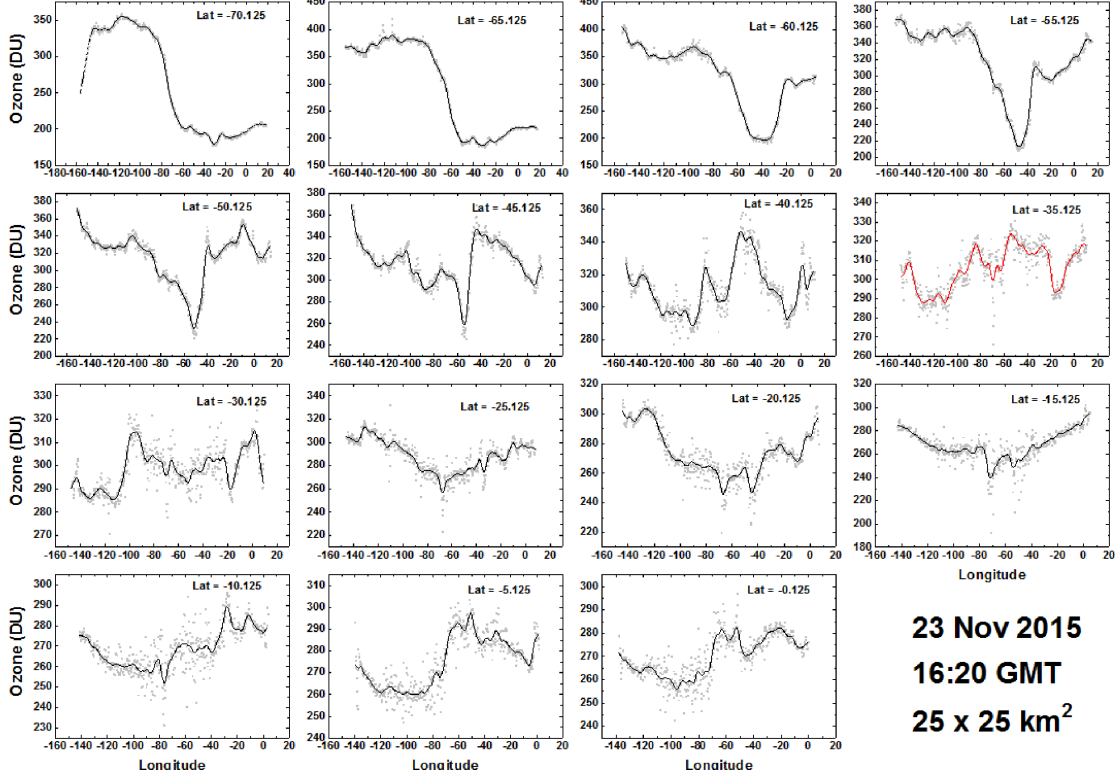
Figure 11. Longitudinal or diurnal variation of ozone for the Southern Hemisphere every 5 ◦ degrees from 0 to 70 ◦ S for 23 November 2015 at 16:20 UTC. The grey points are the individual data points in the band. The solid lines are a LOWESS(0.05) fit to the data points representing a solar time average from 0.6 to 0.7h depending on latitude. The SZA is limited to ± 70 ◦ . Longitude = 0 corresponds to 16:20 local time, and longitude =− 150 corresponds to 06:20 local time.